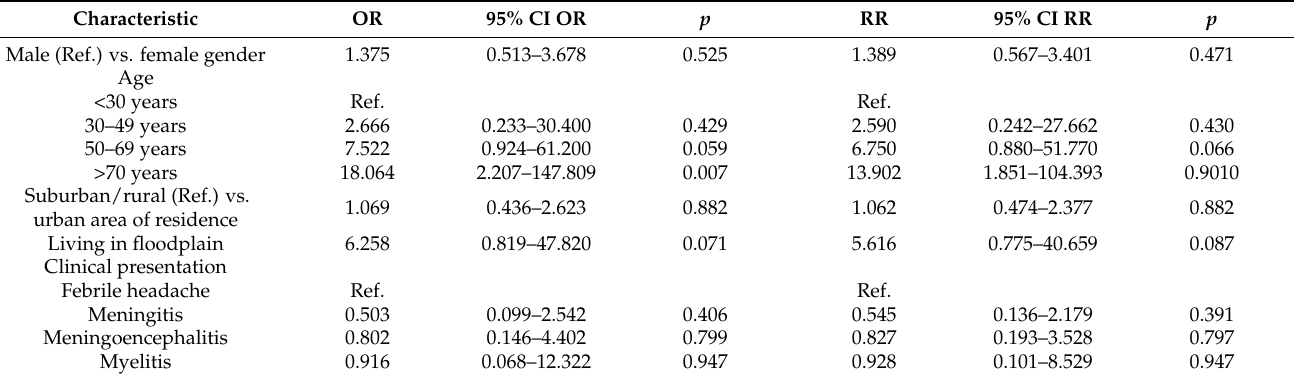
Table 5. Risk analysis for TAHV seropositivity.